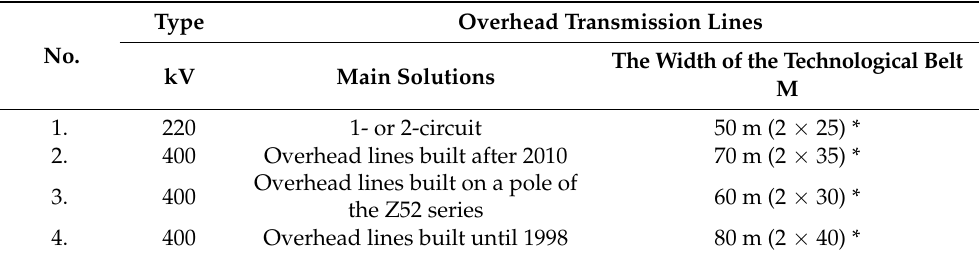
The Width of the Technological